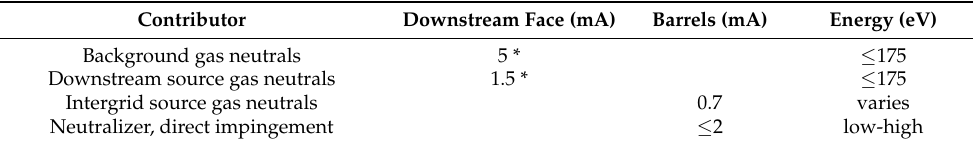
Table 4. Rough estimate of accelerator grid current contributions for